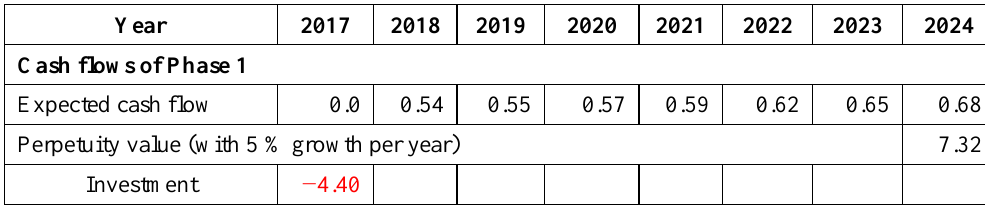
Table 3. Cash Flows of the Investment Program (millions of